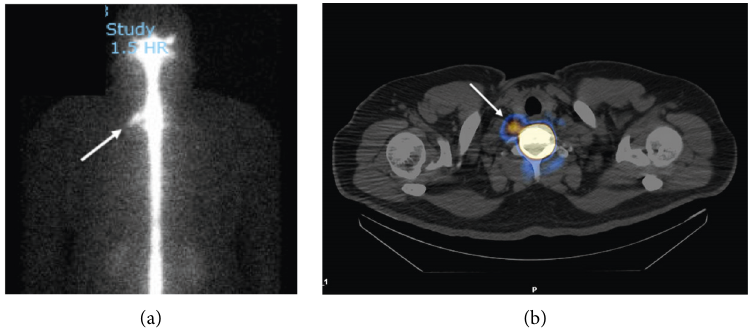
Figure 3: (a) Radionuclide (Tc-99 DTPA) cisternogram at 3-hour interval showed Tc-99 DTPA tracking out at the right of the upper cervical/thoracic vertebrae (white arrow). (b) SPECTat 2-hour time interval, axial view, showed focal extrathecal tracer accumulating at the right anterolateral aspect of the C7/T1 level (white